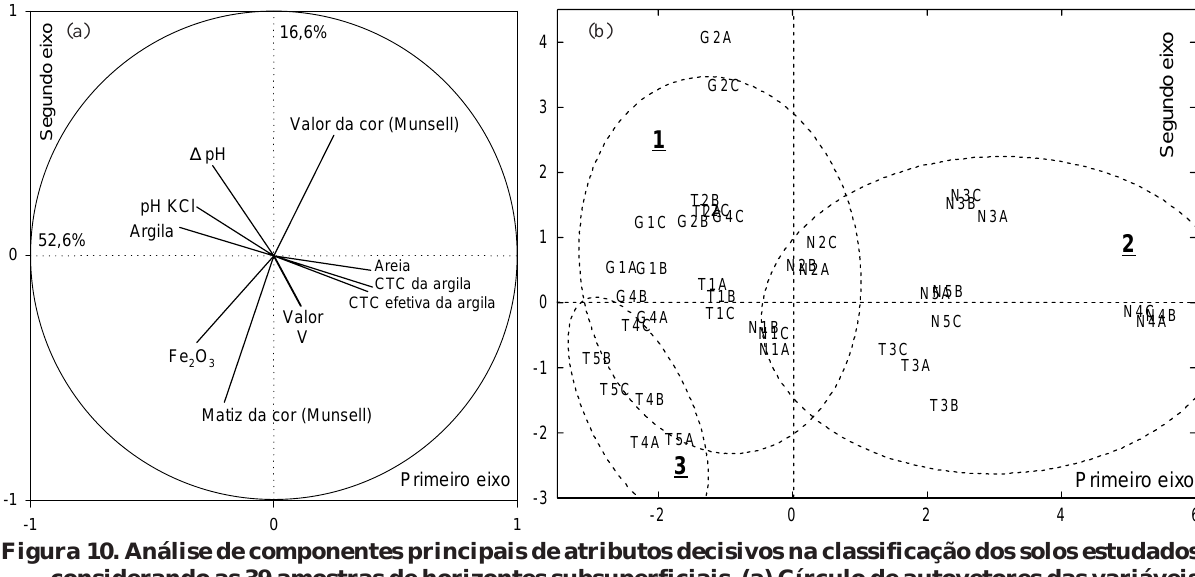
Figura 10. Análise de componentes principais de atributos decisivos na classificação dos solos estudados, considerando as 39 amostras de horizontes subsuperficiais. (a) Círculo de autovetores das variáveis; (b) Plano de elipses e dispersão de pontos dos grupos de perfis de solos. Pontos como códigos de cada perfil. Elipses: 1 = solos de textura argilosa a muito argilosa, hipo a mesoférricos; 2 = solos de textura média a arenosa, hipoférricos; 3 = solos de textura argilosa a muito argilosa,